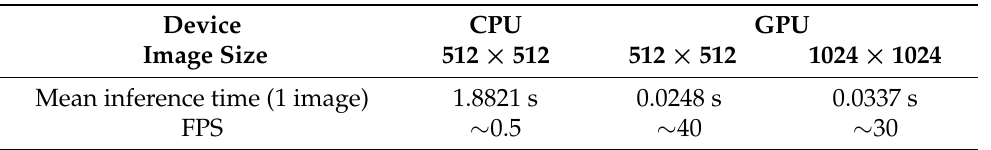
Table 7. Average inference time and frames per second of CurL-Defog. All the tests were performed using 100 images from the LIVE image defogging test set